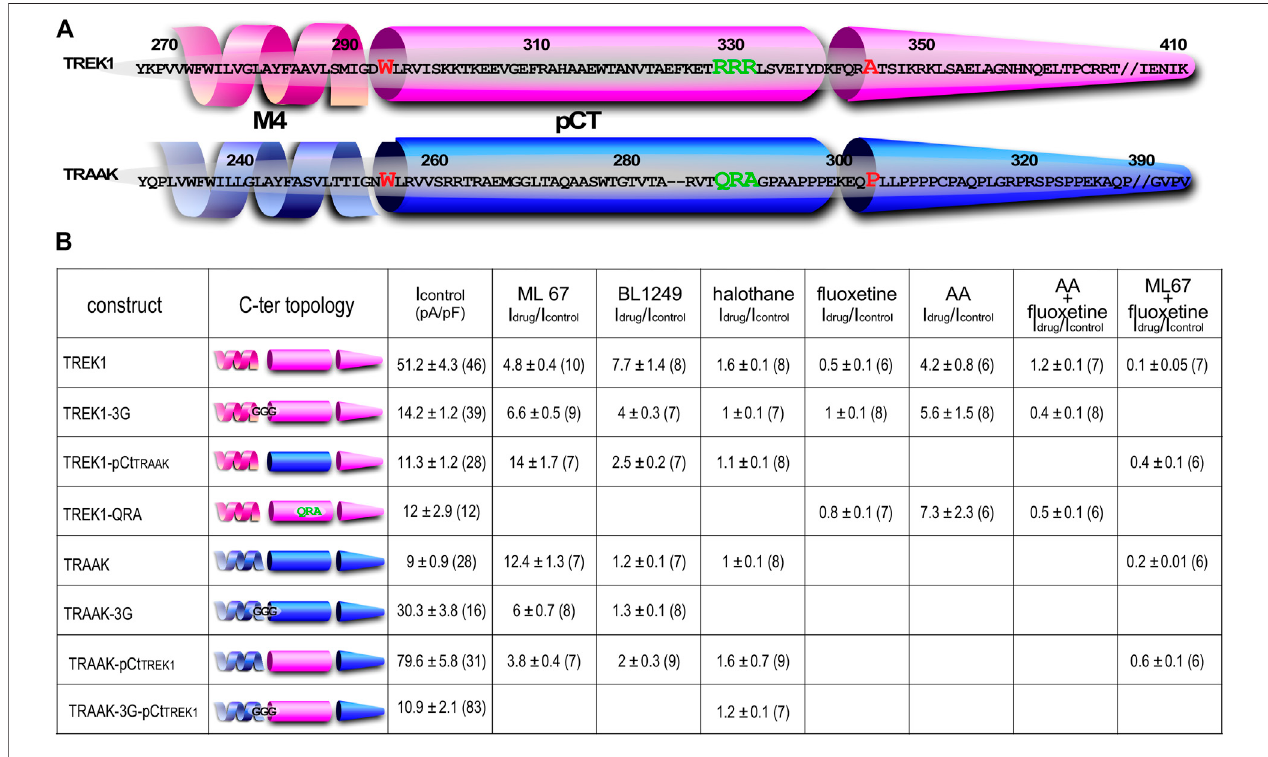
FIGURE 1 | Sequence alignment and Idrug/Icontrol ratios. (A) Alignment of human TREK1 and TRAAK (M4: membrane-spanning segment 4, pCt: proximal C-ter domain).The residues (IGD forTREK1and IGN ofTRAAK) substituted bythreeglycinesin TREK1-3G and TRAAK-3Gmutants areshown.Theresidues fl ankingTREK1 pCt (W295 and A343) and TRAAK pCt (W256 and P302) are in red. The residues forming a PIP 2 binding site in TREK1 (RRR), and the analogous residues (QRA) in TRAAK, are in green. This triplet R229-R230-R231 is substituted by QRA in TREK1-QRA. (B) I drug /I control ratios of the corresponding channels. I drug and I control are the currents measured at 0 mV (pA/pF) in the presence and absence of drug as speci fi